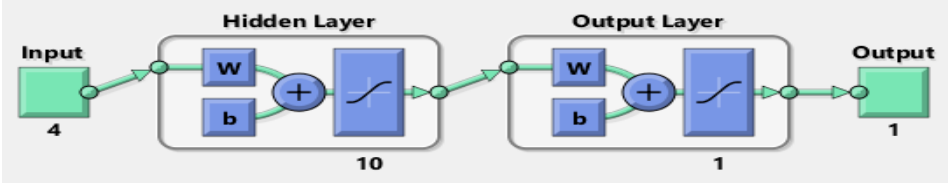
Figure 6. ANN structure. Figure 6. ANN